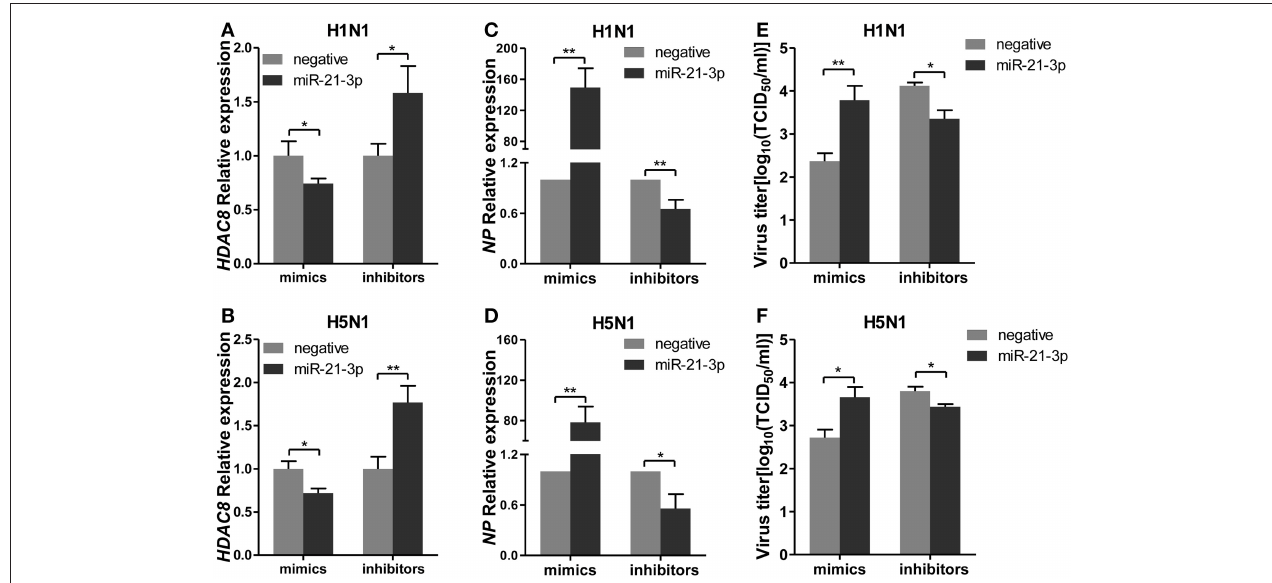
FIGURE 7 | miR-21-3p promotes IAV replication. A549 cells plated in 24-well plates were transfected with mimics or inhibitors of miR-21-3p and their negative control (mimics: 50nM; inhibitors: 100nM). Twenty-four hours after transfection, cells were infected with H1N1 or H5N1 at a MOI of 0.1. (A,B) After 48 hpi, the relative HDAC8 mRNA levels were analyzed by real-time qPCR and normalized to that of GAPDH . Data are the mean ± SD of triplicate samples from a single experiment and are representative of two independent experiments. * P < 0.05 and ** P < 0.01 by t -test. (C,D) Viral NP vRNA was analyzed at 48 hpi by real-time qPCR. Data are the mean ± SD from four independent experiments. * P < 0.05 and ** P < 0.01 vs. negative control by t -test. (E,F) Virus titers in supernatants were measured at 48 hpi by the TCID50 assay performed on MDCK cells. Viral titers are the mean ± SD from at least three independent experiments. * P < 0.05 and ** P < 0.01 vs. negative control by t